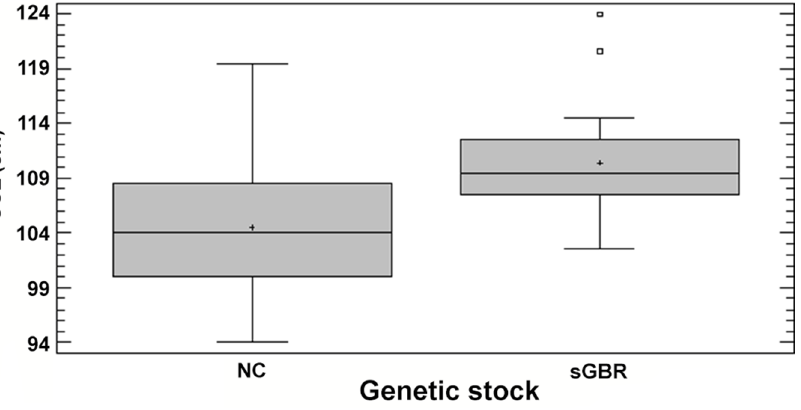
Figure 5. Mean CCL (cm) ( 6 SE) at two nesting areas in the Coral Sea. sGBR (n=15) and NC (n=32).